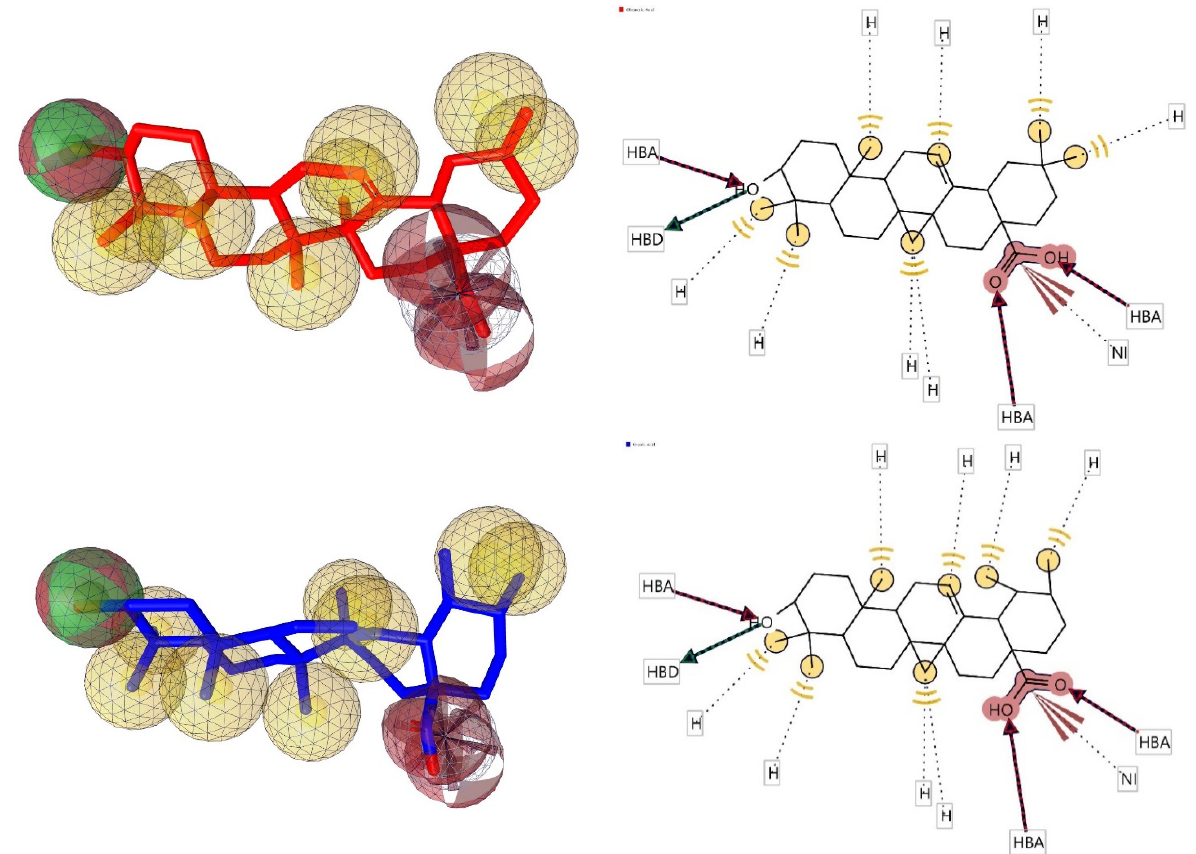
Figure 7. 3D and 2D representations of pharmacophoric features of Oleanolic acid and Ursolic acid used in 3D pharmacophore generation. Red, HBAs; green, HBDs; Yellow, H; Brown, NI as described earlier.